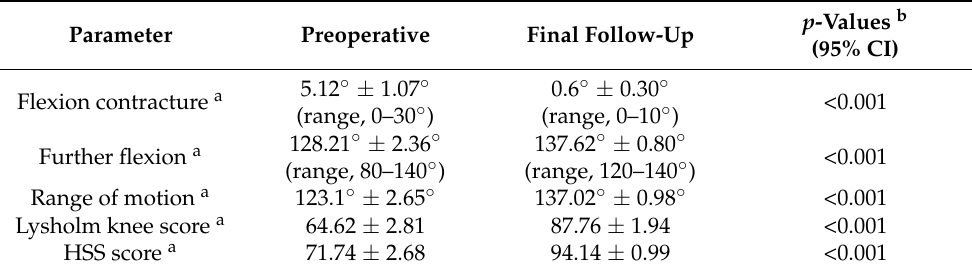
Table 4. Preoperative and final follow-up clinical outcomes ( n = 42).